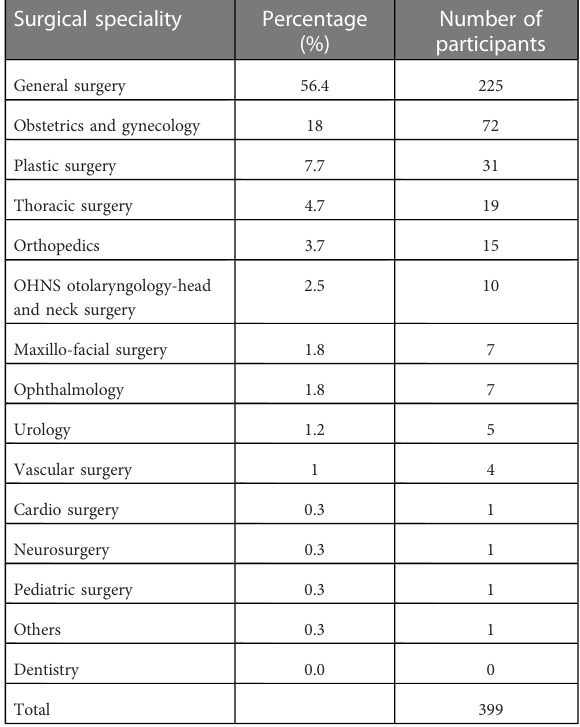
TABLE 1 Subdivision according to surgical specialty.